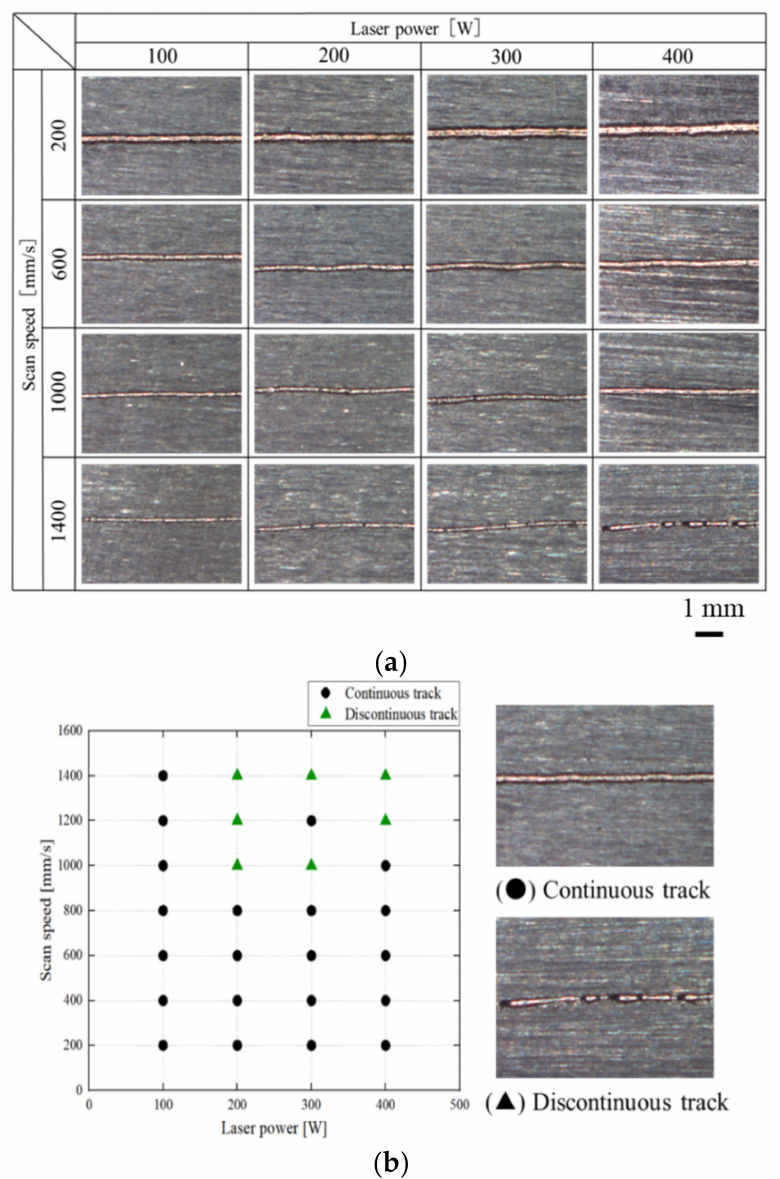
Figure 4. The SEM images of single tracks and the process map in terms of laser power and scan speed evaluated by the morphology of single tracks fabricated under condition II (Laser spot diameter: 0.2 mm). ( a ) SEM images of single tracks; ( b ) process map in terms of laser power and scan speed evaluated by the morphology of single